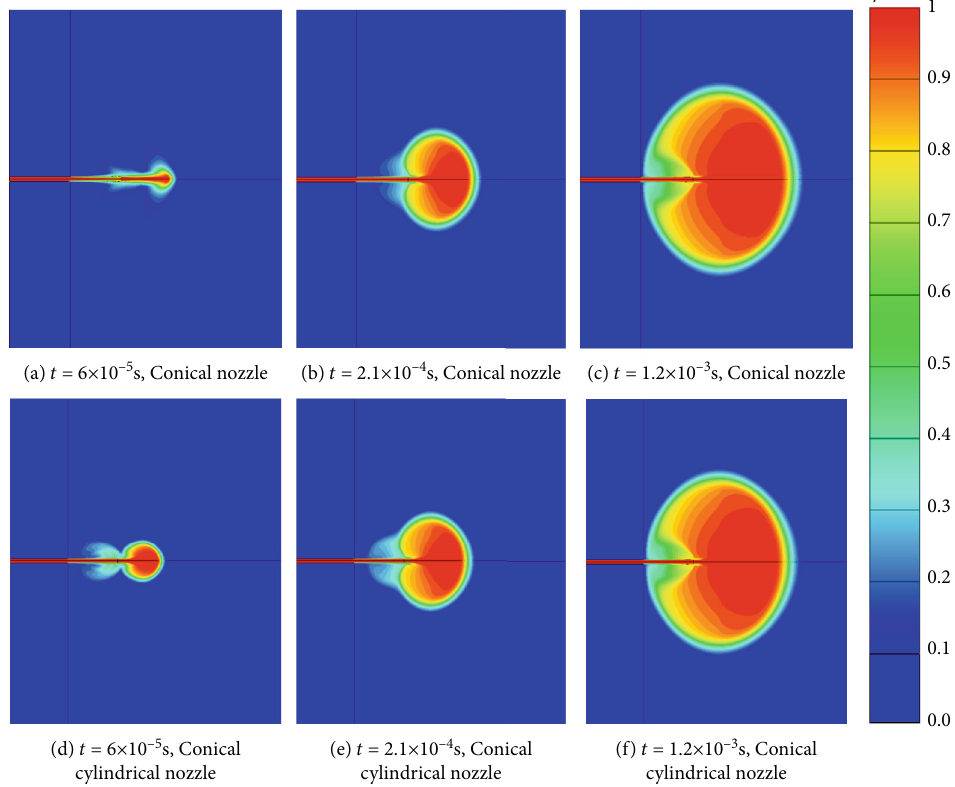
Figure 7: Comparison of drug di ff usion process with di ff erent nozzle geometries. (a) t = 6 × 10 − 5 s , conical nozzle. (b) t = 2 : 1 × 10 − 4 s , conical nozzle. (c) t = 1 : 2 × 10 − 3 s , conical nozzle. (d) t = 6 × 10 − 5 s , conical cylindrical nozzle. (e) t = 2 : 1 × 10 − 4 s , conical cylindrical nozzle. (f) t = 1 : 2 × 10 − 3 s , conical cylindrical nozzle.